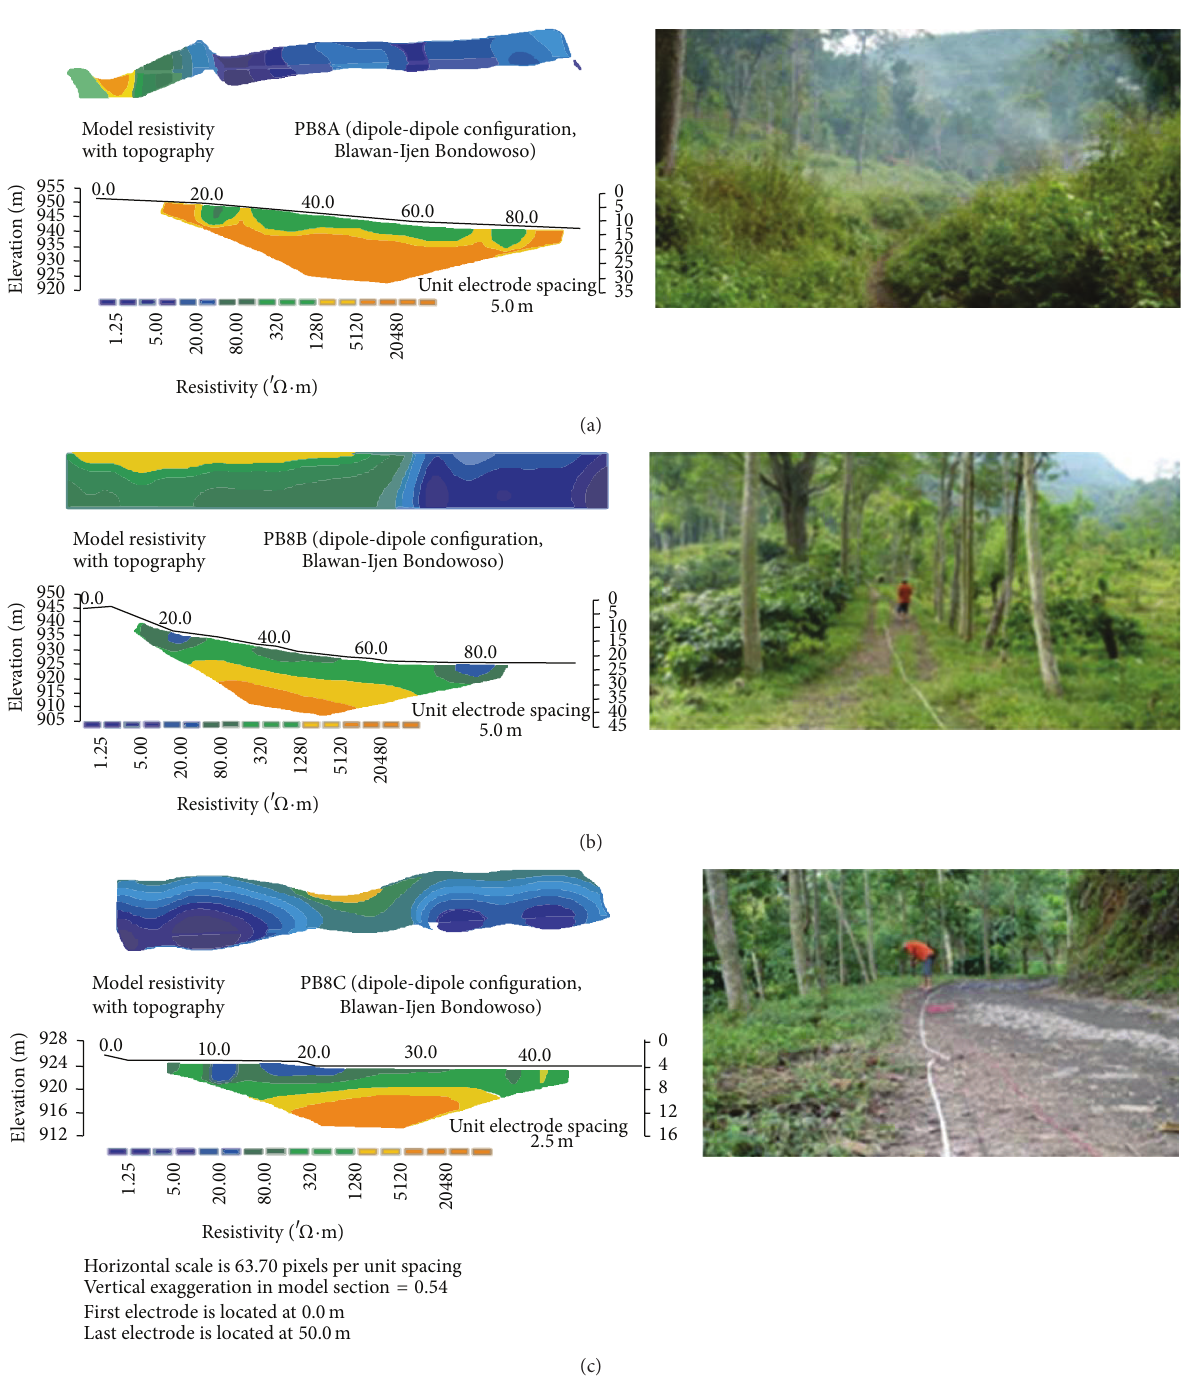
Figure 12: 2D Resistivity Mapping and GPR amplitude slice in locations (a) PB8A, (b) PB8B, and (c) PB8C.